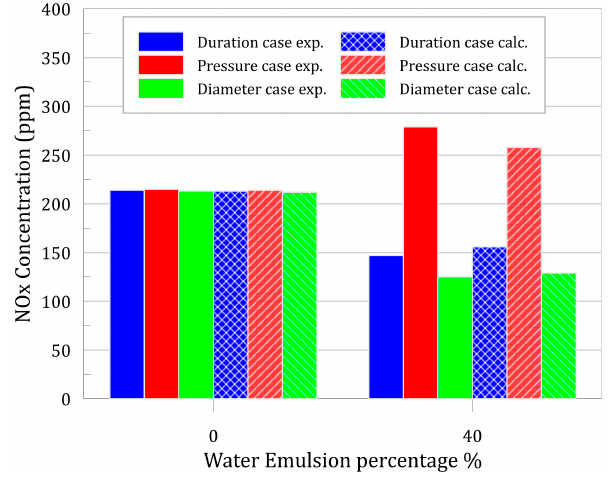
Energies 2023 , 16 , x FOR PEER REVIEW Figure 11. NOx emissions in the WFE calculations versus the experiments. Figure 11. NOx emissions in the WFE calculations versus the experiments.